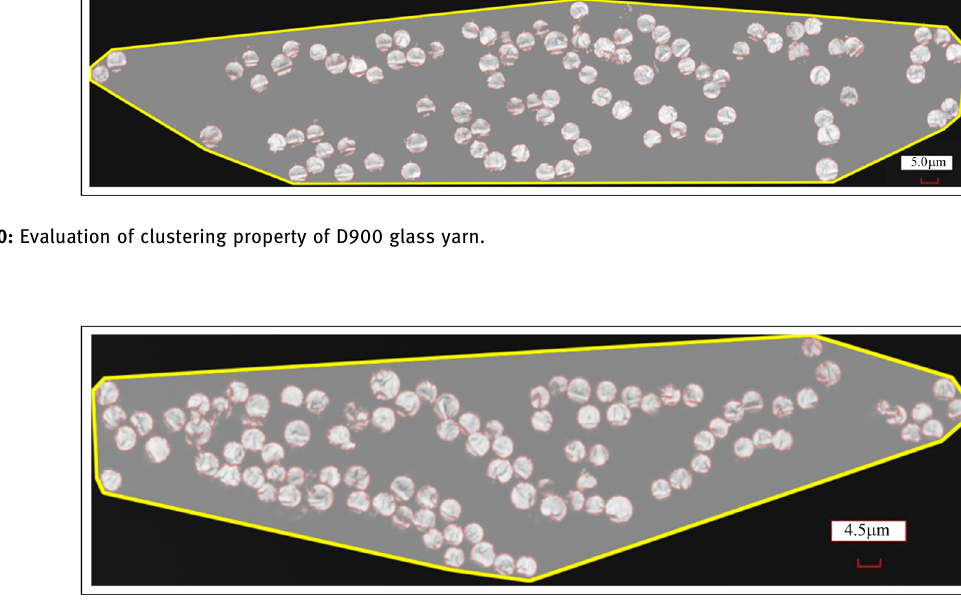
Figure 11: Evaluation of clustering property of BC1500 glass